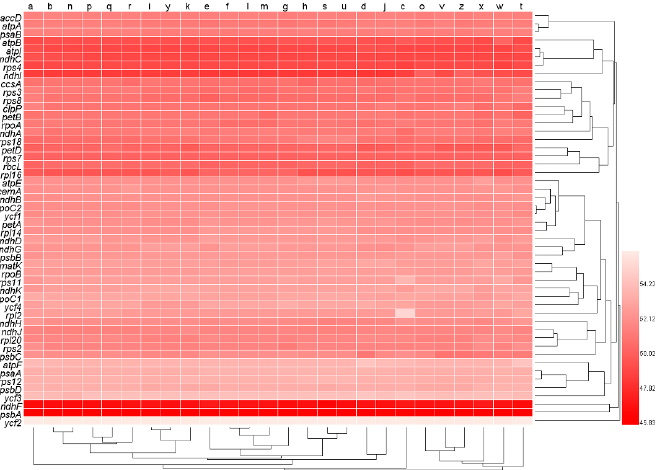
Figure 3. Codon usage bias measured by effective number of codons ( N c ) of all genes. The numbers next to the legend indicate values of N c . Lowercase letters from a to z at the top of the heat map represent the data sets of oak trees Q. rubra , Q. aliena , Q. spinose , Q. aquifolioides , Q. baronii , Q. variabilis , Q. dolicholepis , Q. tarokoensis , Q. glauca , Q. tungmaiensis , Q. sichourensis , Q. chenii , Q. acutissima , Q. dentate , Q. obovatifolia